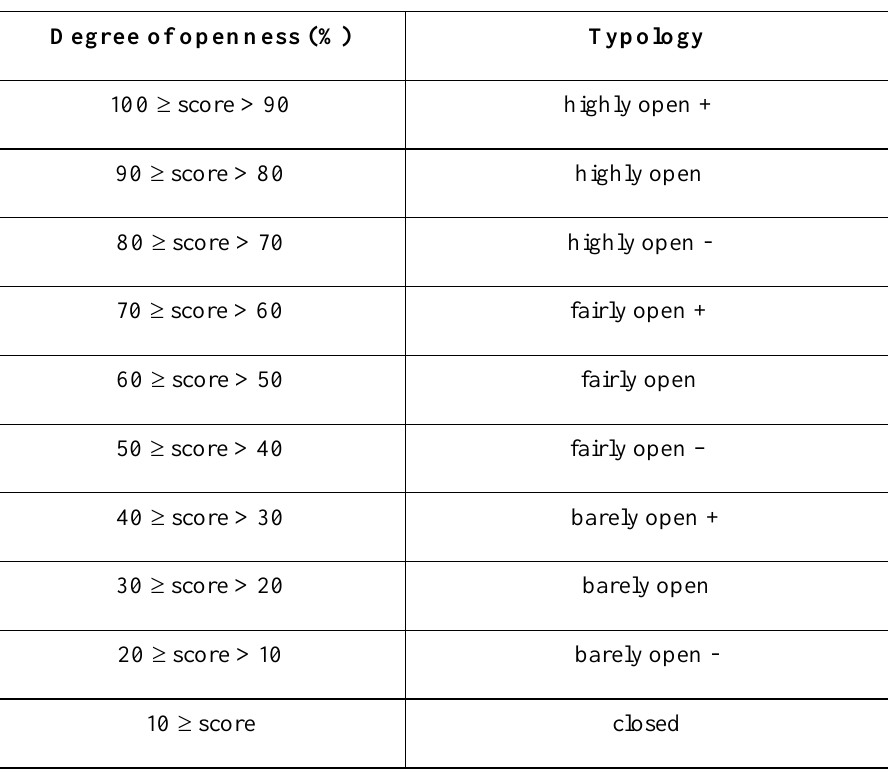
The Typology of Openness (Jézégou, 2010a, p.